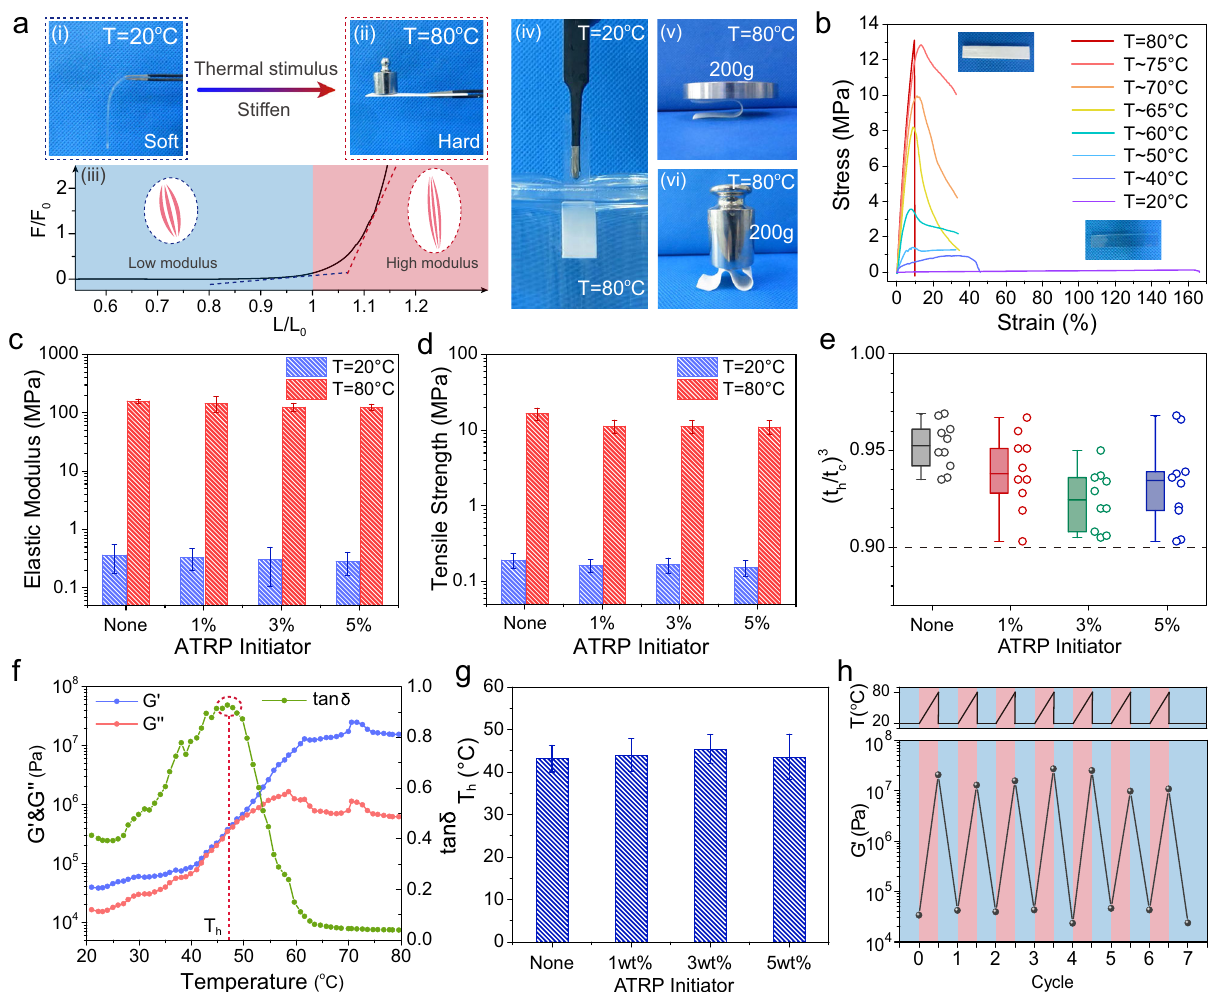
Fig. 3 Switchable mechanical state of MALH in response to temperature. a Demonstration for the phase-separation dominated mechanical characteristics of MALH at soft sate (20 °C) and rigid state (80 °C) (i, ii, iv), (iii) the schematic J-shaped curve of strain-stiffening mechanism of muscle ( L was the tensile length, L 0 was the rest length of muscle, F was the tensile force, F 0 was the maximum isometric force) 35 , (v, vi) demonstration for the load-bearing and shape- fi xing capacity of MALH at rigid state. b Tensile test results of hydrogels with 3 wt% initiator from 20 to 80 °C. c The effect of the content of HEMA- Br (ATRP initiator) on elastic modulus and d tensile strength of MALH, the data were presented as mean ± SD and sample size n = 6. e Ratio of MALH volume change before and after phase separation, sample size n = 10 ( t c and t h were the length before and after MALH phase separation, respectively; t h / t c was the one-dimensional length change ratio, ( t h / t c ) 3 was the volume change ratio.). f Temperature-sweep rheological pro fi le of MALH with 3 wt% ATRP initiator. g Phase-separation temperature ( T h ) of MALH with different ATRP initiator content, the data were presented as mean ±SD and sample size n = 8. h Cyclic tests demonstrating reversible phase-separation behavior of MALH with 3 wt% ATRP initiator.